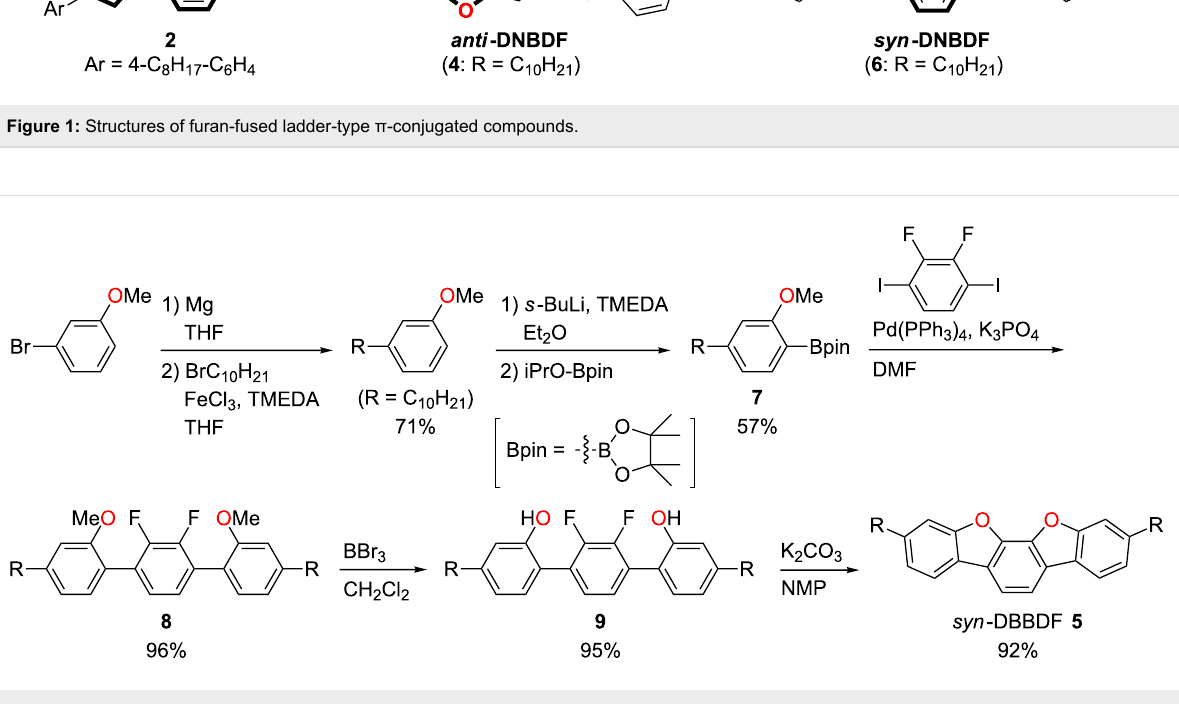
Scheme 1: Synthesis of syn -DBBDF 5